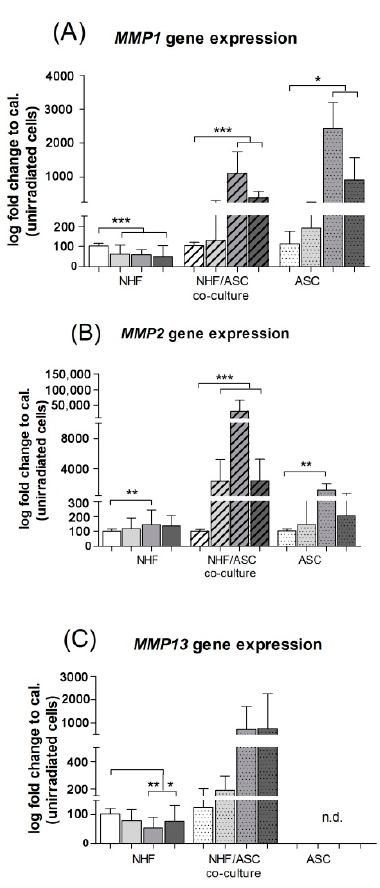
Figure 2. Relative expression of MMP1 ( A ); MMP2 ( B ) and MMP13 ( C ) mRNA in normal human fibroblasts (NHF), adipose-derived stem cells (ASC) and the co-culture NHF/ASC 48 h after irradiation with 2–12 Gy as determined by PCR. Error bars represent standard error of the mean ( n = 7). * p < 0.05, ** p < 0.01, *** p < 0.001. n.d. means not